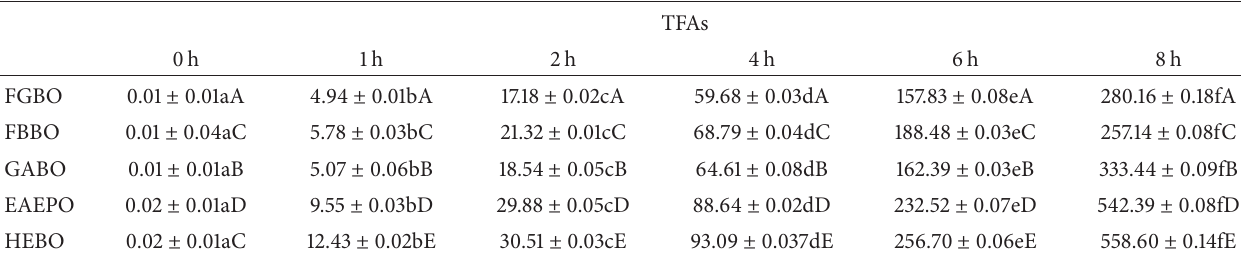
Table 6: Changes in trans-fatty acid profile (mg/mL).